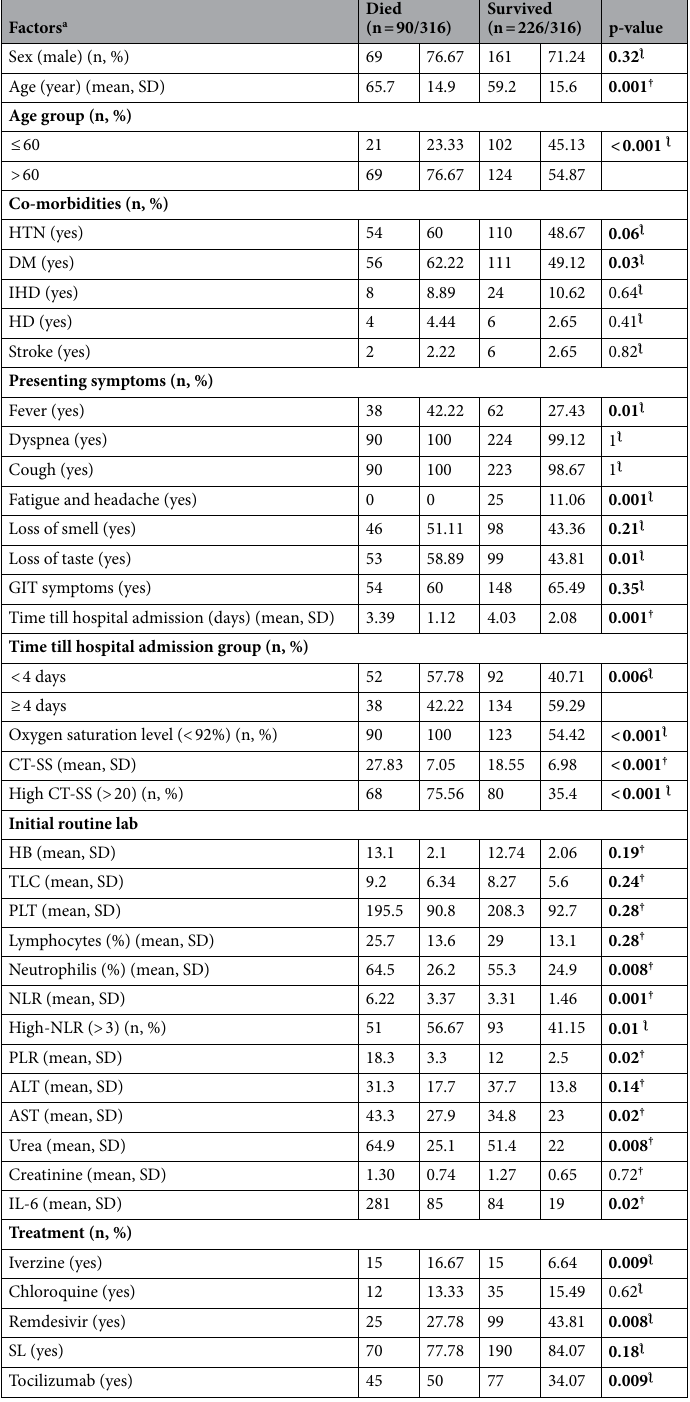
Table 1. Socio-demographic data and clinical characteristics. DM: Diabetes mellitus, HTN: Hypertension, IHD: ischemic heart disease, HD: hepatic disease, DOC: duration of complain, CT-SS: Ct severity score, TLC: total leucocytes count, PLT: platelets, NLR: neutrophil lymphocytic ration, PLT, platelets lymphocyte ratio, ALT: Alanine transaminase, AST: Aspartate transaminase, IL-6: Interleukin-6, SL: Sofosbuvir/Ledipasvir, †: Independent t-test, ƪ : Chi-square test. Significant values are in bold. a The parametric data presented as mean and stander deviation (SD), and categorical data as number and percentage